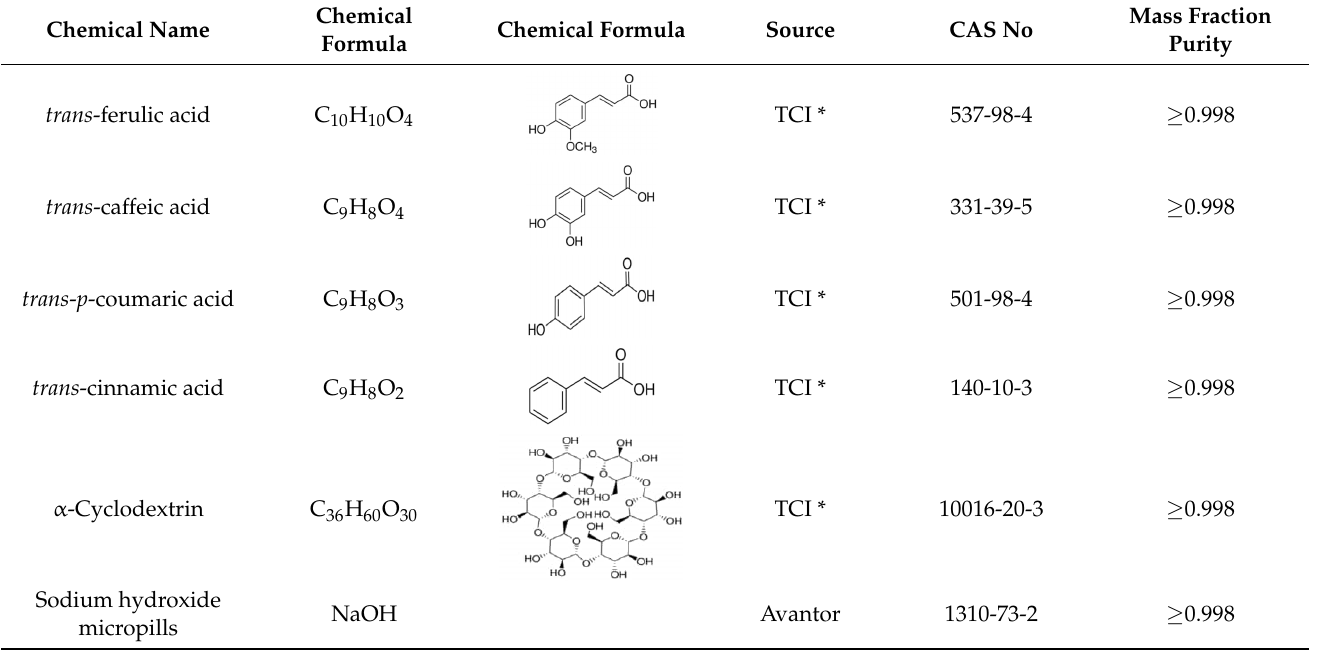
Table 1. Specification of chemical samples.